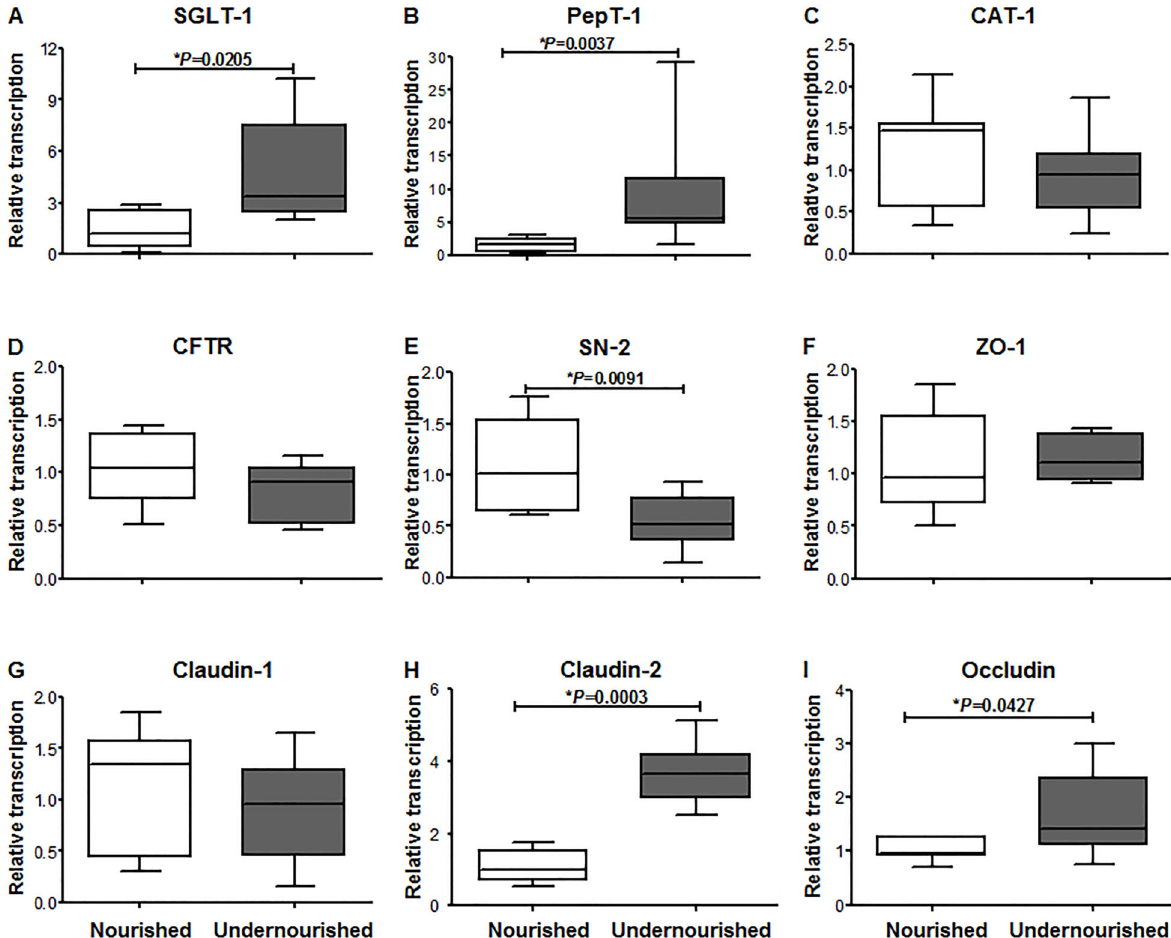
Figure 6. Effects of the regional basic diet on relative expression of A , SGLT-1; B , PepT-1; C , CAT-1; D , CFTR; E , SN-2; F , ZO-1; G , claudin-1; H , claudin-2; I , occludin. *P o 0.05, Mann-Whitney test (n=7).